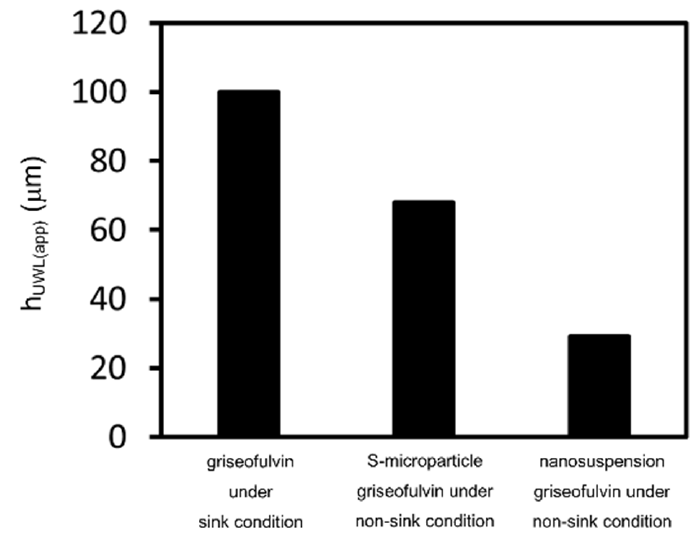
Figure 10. Calculated unstirred water layer (UWL) thickness under sink and non-sink conditions for microparticle samples and for nanosuspensions.